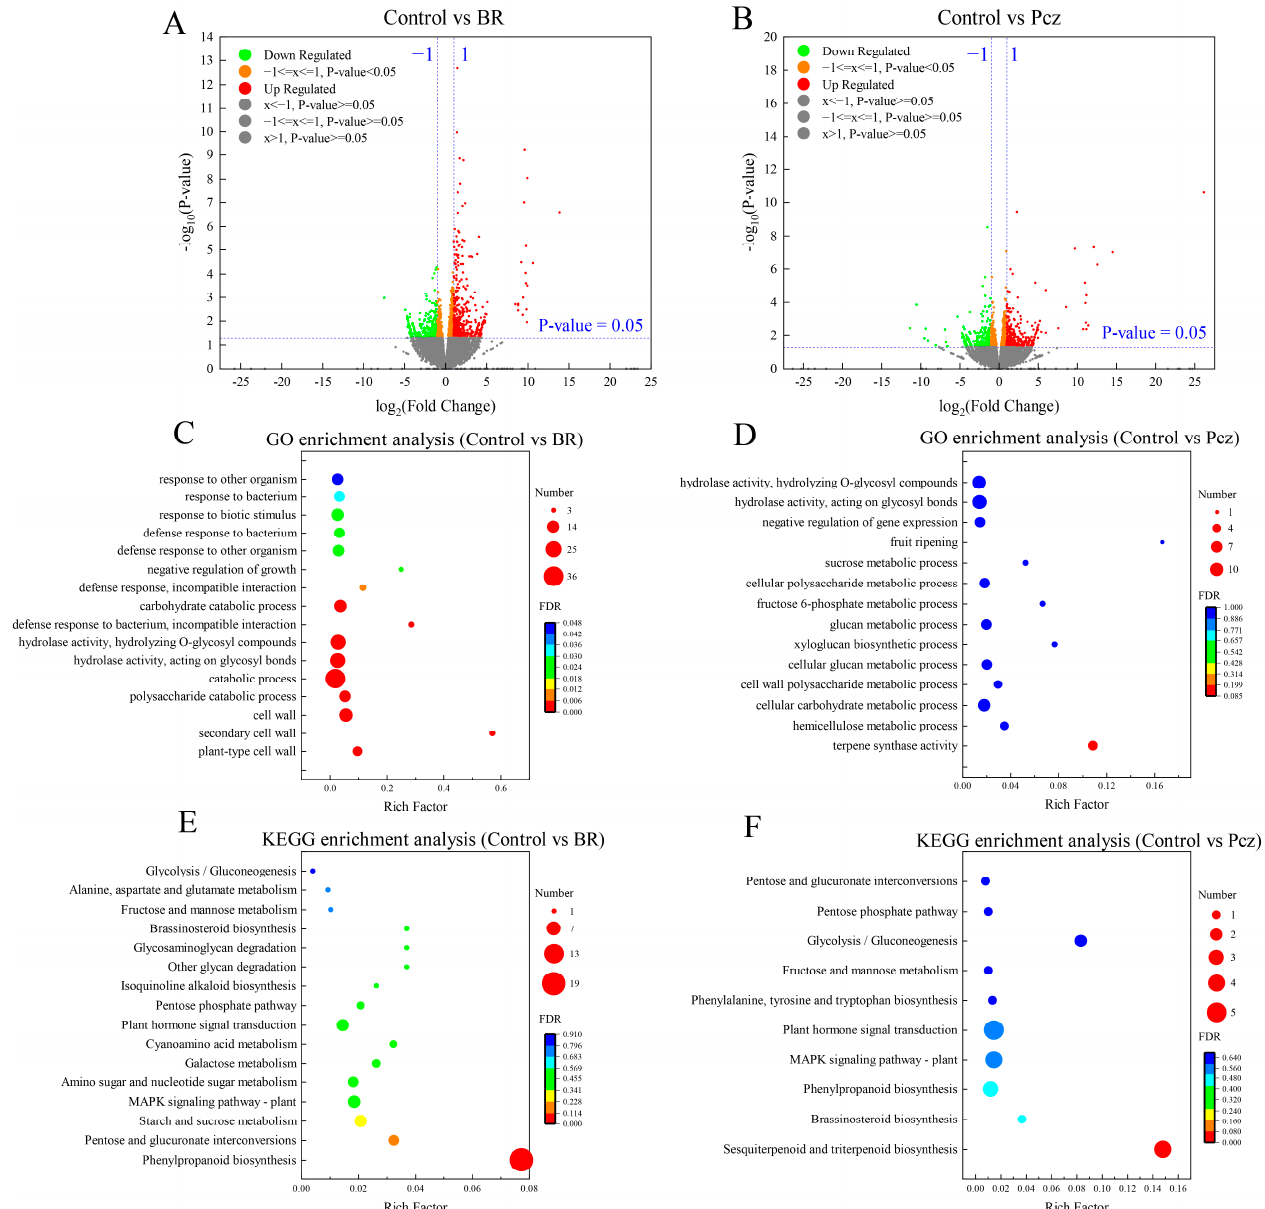
Figure 2. Identification and functional information of differential expression genes (DEGs) among control, BR, and Pcz treatments in P. ternata . ( A ) volcano of DEGs in control and BR groups; ( B ) volcano of DEGs in control and Pcz groups; ( C ) GO enrichment analyses with the DEGs generated in control and BR groups; ( D ) GO enrichment analyses with the DEGs generated in control and Pcz groups; ( E ) KEGG enrichment analyses with the DEGs generated in control and BR groups; ( F ) KEGG enrichment analyses with the DEGs generated in control and Pcz groups.